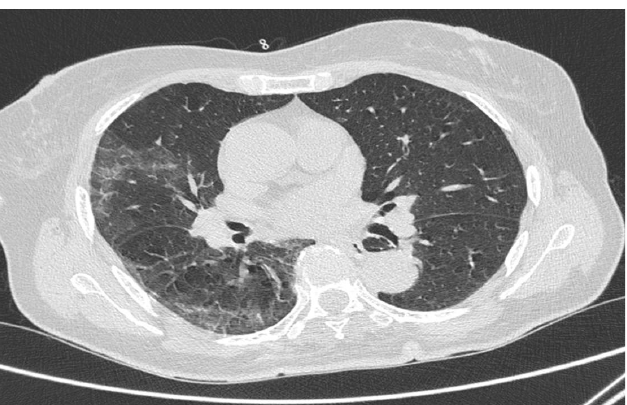
Figure 2. Ct scan of a 62-year-old woman vaccinated with Ad26.COV2.S suffering from COVID-19 interstitial pneumonia. CO-RADS 3 was estimated (confirmed by molecular swab), with an RSNA CT severity score of 12 points. The patient was admitted to ordinary care.